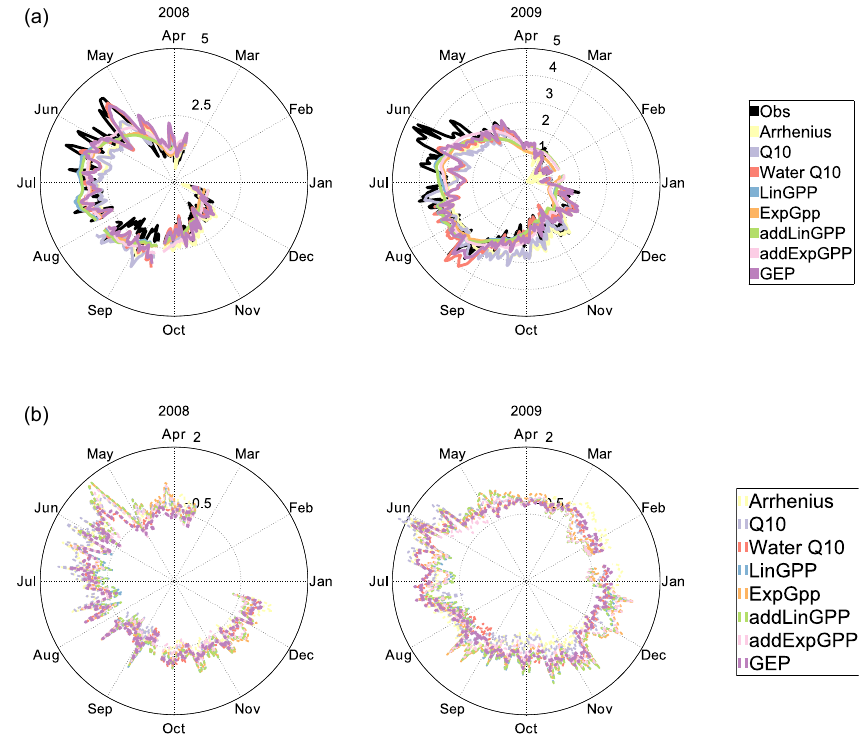
Figure 15. Daily R soil fluxes (a) illustrated in the context of the 2 studied years and residual values (b) of the total soil daily CO 2 outgoing fluxes as simulated by the investigated literature models and the GEP emerged model after smear term bias corrected back-transformation. The fluxes shown here are the real flux measured at the site and the predicted fluxes generated according to the GEP model and some of the models used in the environmental science community. The centre of the plots in the second row is − 1. The scale of the fluxes is given in gCm − 2 day − 1